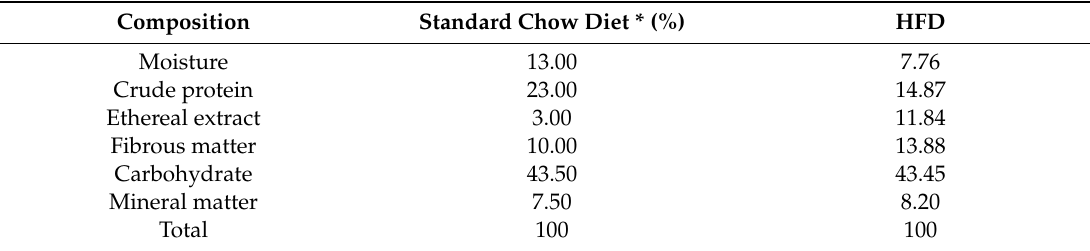
Table 1. Composition of the experimental standard chow diet.